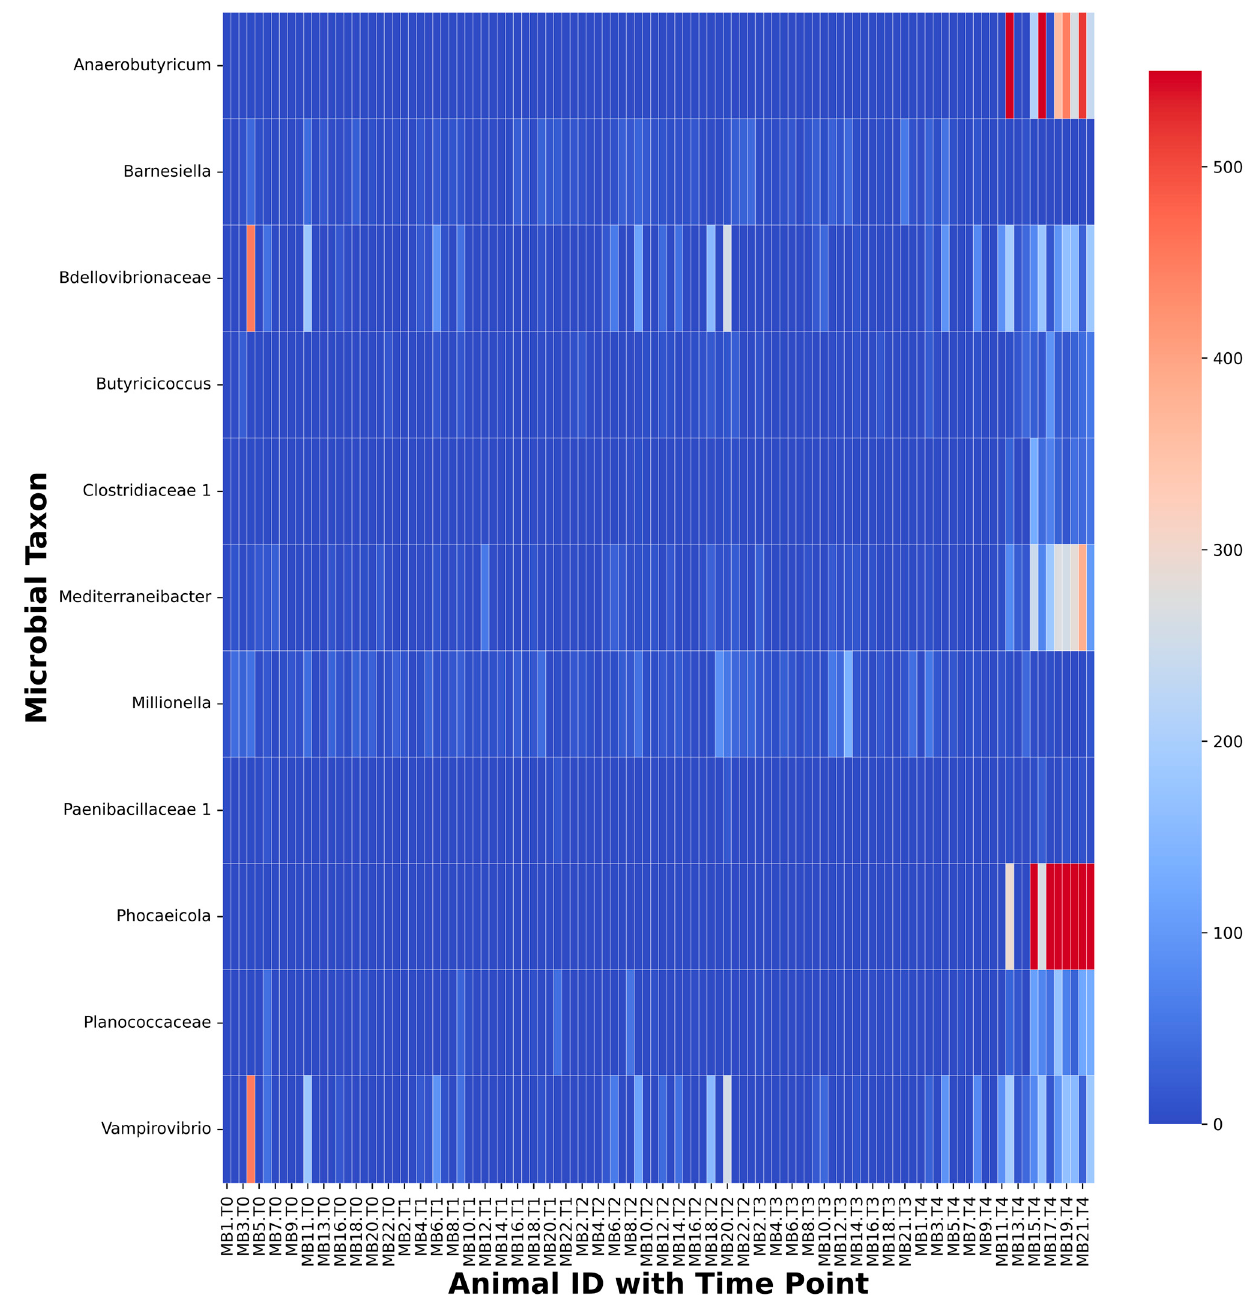
Figure 3. Heatmap depicting taxa that exhibited significant changes in abundance between five time points for all animals. Cells in red indicate higher abundance, whereas blue indicates lower abun- dance. The scale on the right indicates the heatmap scale. For clarity, x -axis labels show information for every other fecal sample included in the analysis. Ruminococcus were not included here, because the higher general abundance of this taxon would offset the scale of the heatmap.